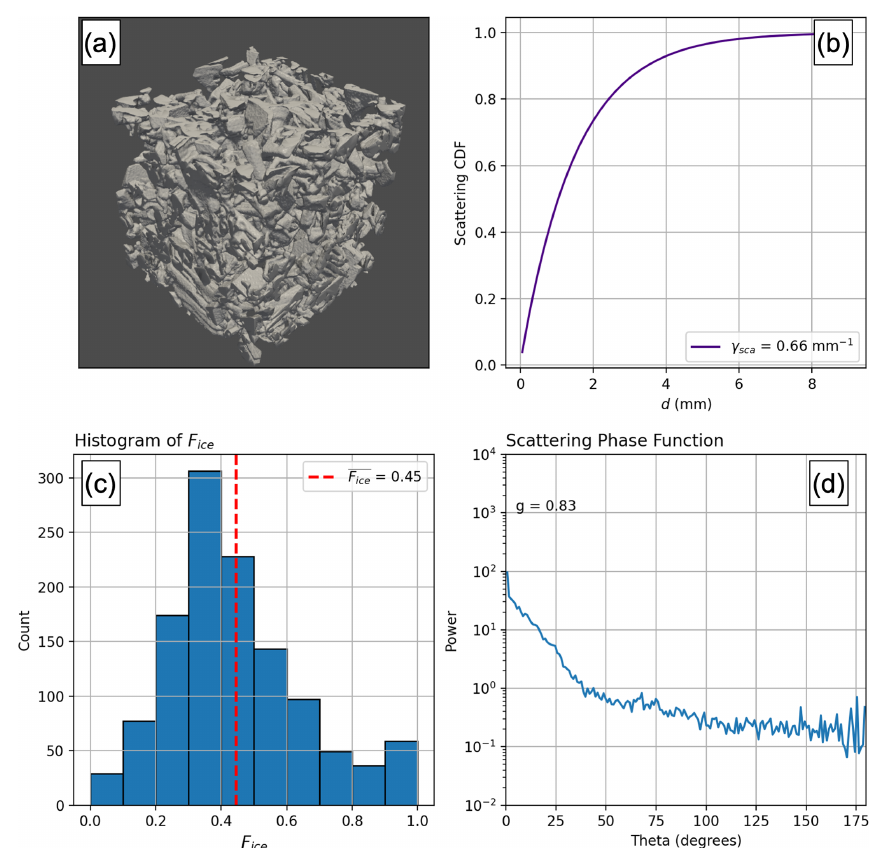
Figure 2. (a) Three-dimensional rendering of the snow sample used to generate the optical properties. (b) Cumulative distribution function of scattering as a function of distance (mm) and γ sca . (c) Histogram of F ice . The dashed red line indicates the mean value. (d) Scattering phase function. A total of 1200 individual photon tracks were used to generate the optical properties shown in this figure. The asymmetry parameter ( g ) is the average of the geometric asymmetry parameter computed from the phase function as g G = 1 and the diffraction asymmetry parameter g D (cid:39) 1 according to Kokhanovsky and Zege (2004) and Libois et al.